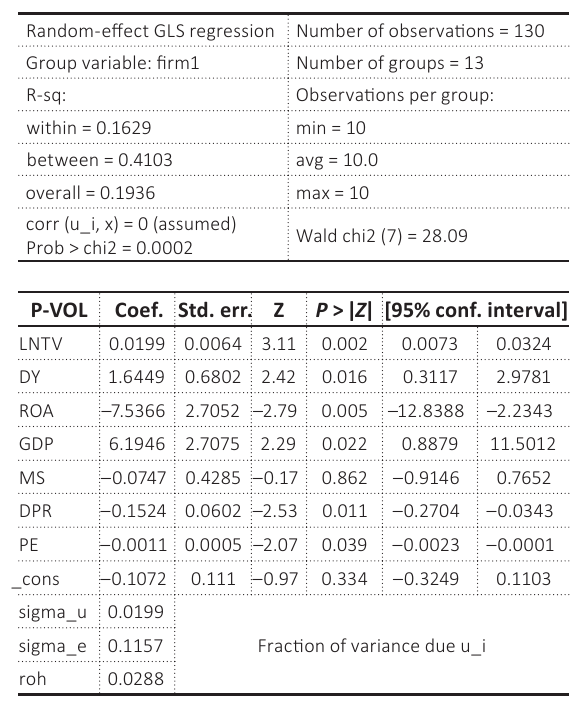
Table 5. Random effect regression